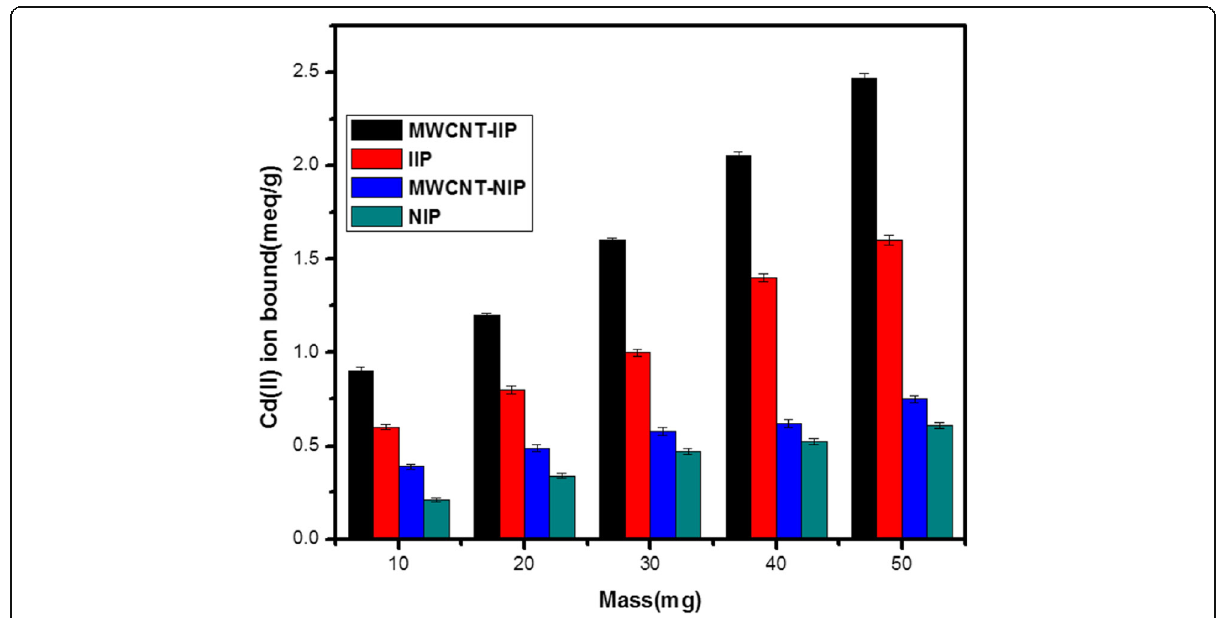
Fig. 18 Effect of adsorbent mass on Cd(II) ion binding